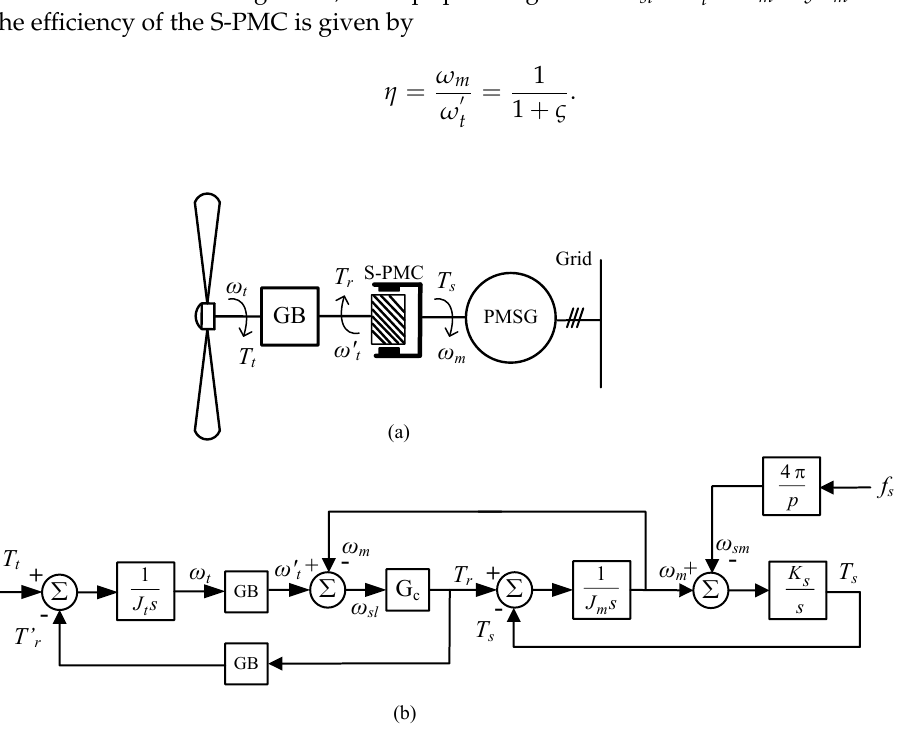
Figure 2. Simplified ( a ) line diagram representation model and ( b ) block diagram model of a geared SS-PMSG